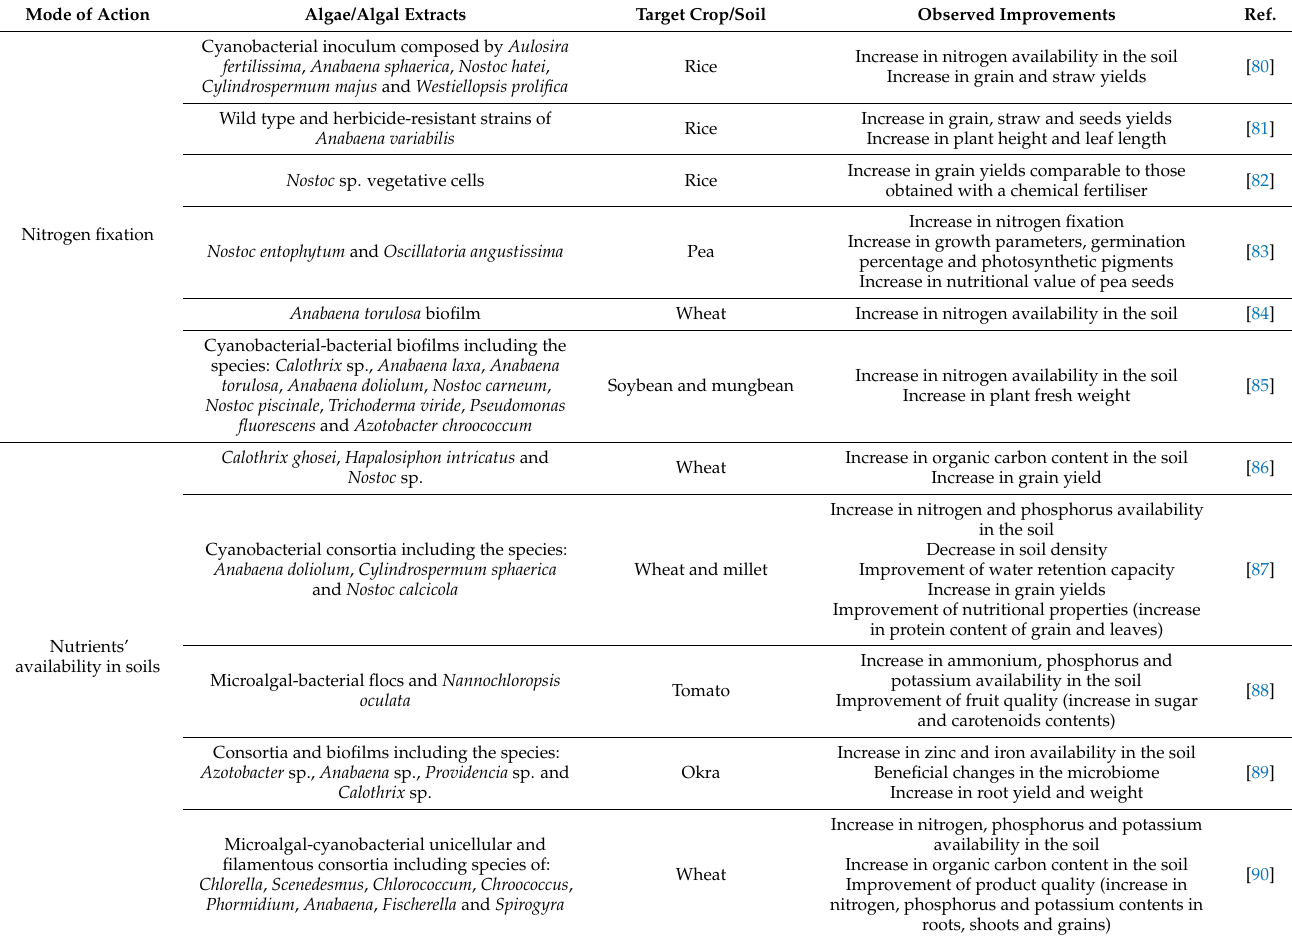
Table 2. Impacts of microalgae and cyanobacteria (and their metabolites) on soils’ improvement. Mode of